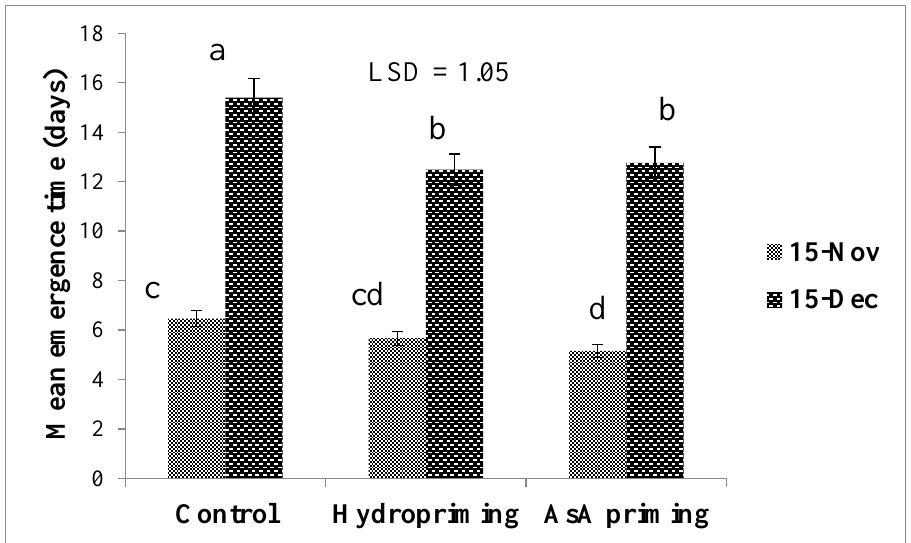
Figure 1. Interaction between priming techniques and sowing dates for mean emergence time (days) during 2016. Means not sharing same letter (s) differ significantly at p ≤ 0.05.